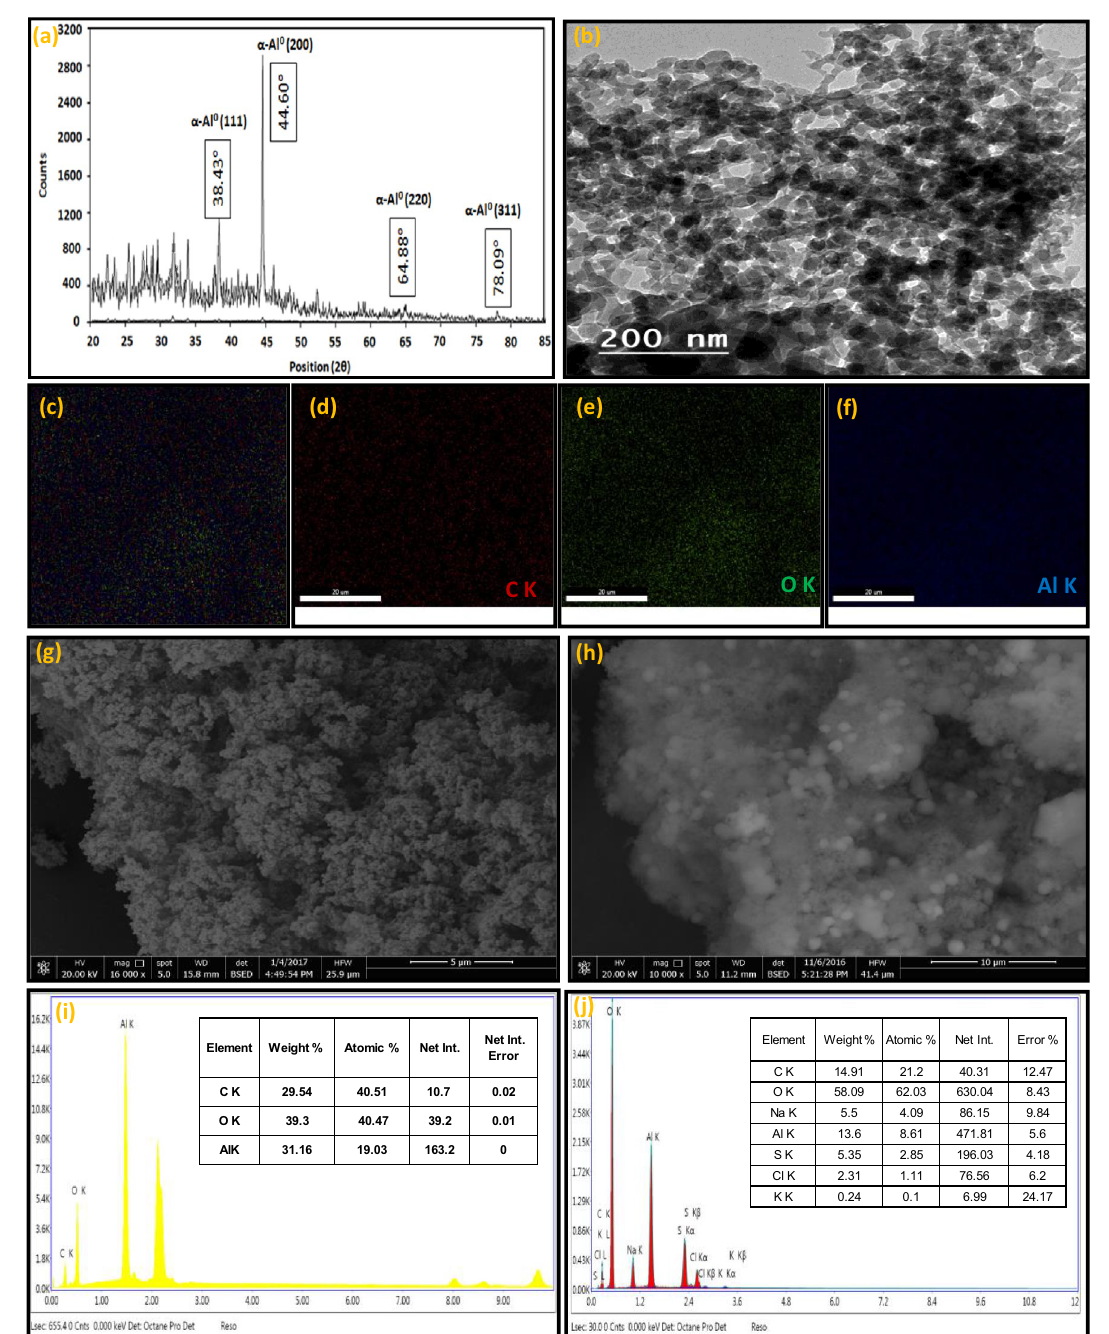
Fig. 2 Characterization of nZVAl by a XRD, b TEM, c – f EDS ele- mental mapping, g SEM image before MB adsorption, h SEM image after MB adsorption, i EDS spectrum (inset: Table of chemical com-